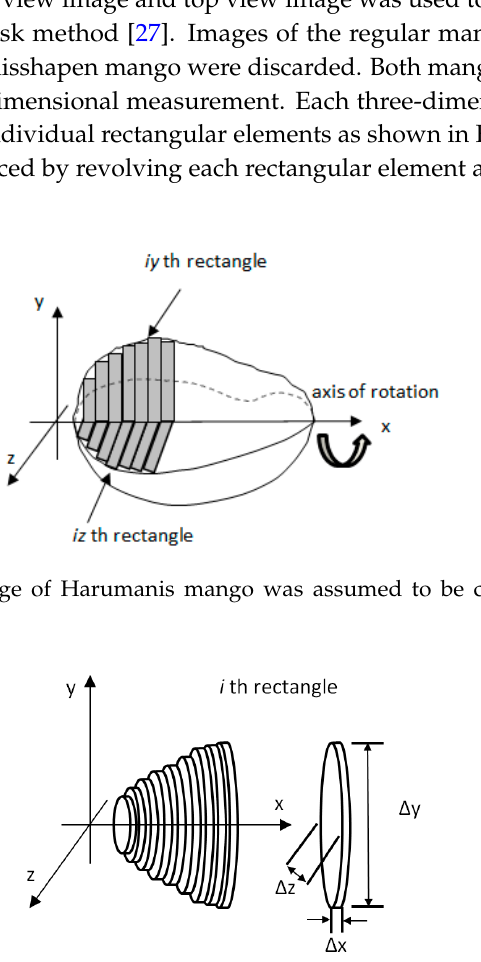
Figure 10. Revolving each rectangular element around x-axis generated an elliptic cylindrical disk.